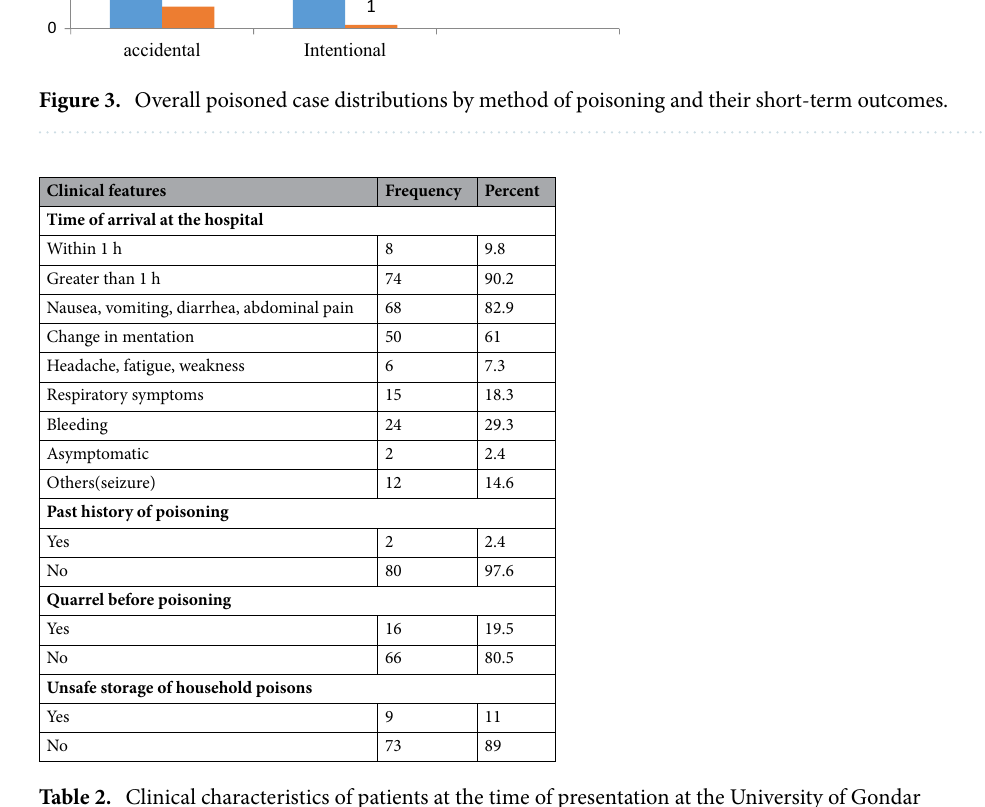
Table 2. Clinical characteristics of patients at the time of presentation at the University of Gondar comprehensive specialized hospital in Northwest Ethiopia (n =